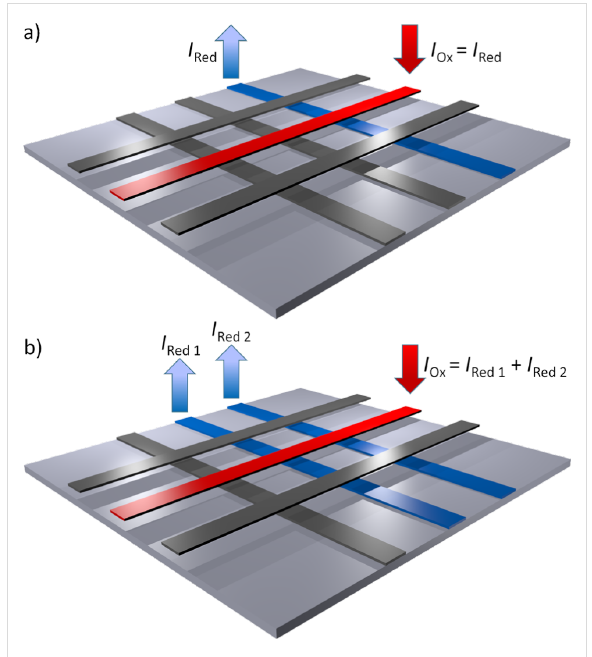
Figure 1: Illustration of the two modes of operation: a) Sequential data acquisition: Each intersection is read out sequentially. b) Parallel data acquisition: Intersections are read out simultaneously in a row-wise